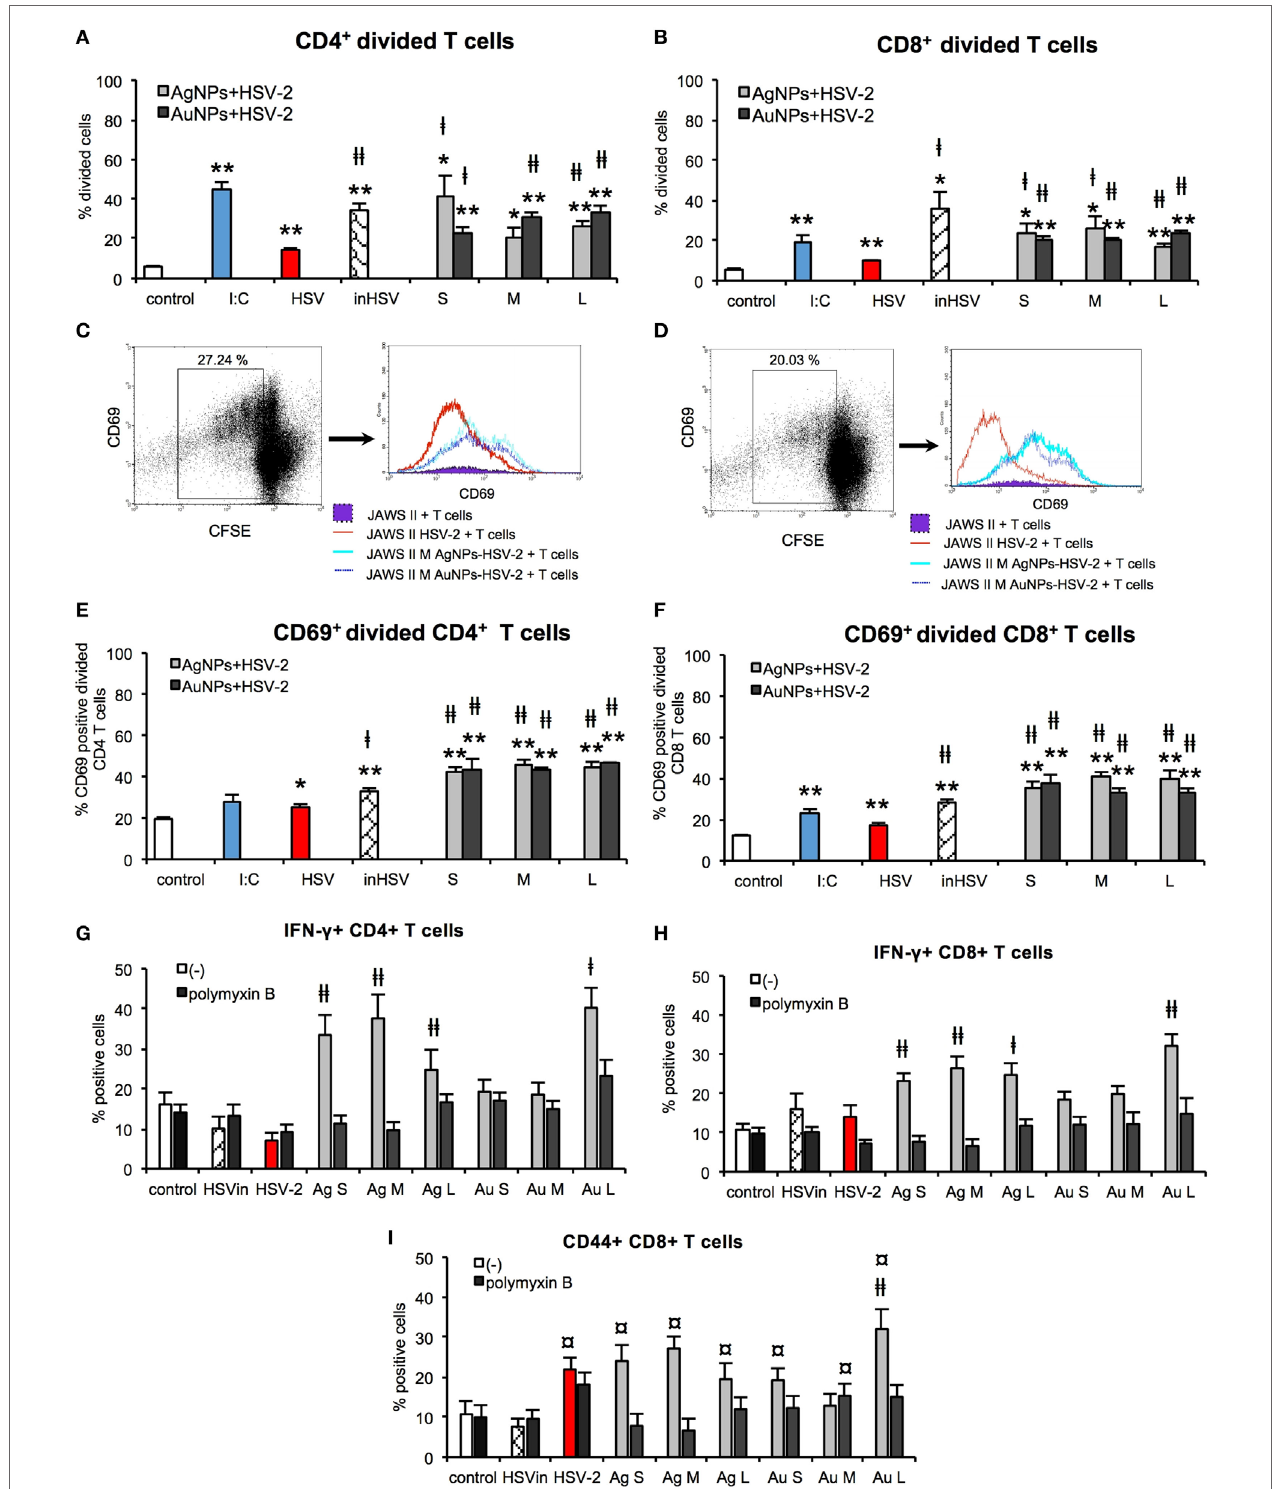
FigUre 11 | Nanoparticles (NPs) enhance the ability of dendritic cells (DCs) to activate T cells in vitro . Percentage of divided CD4 + (a) and CD8 + T cells (b) . Representative dot plots and histogram plots of CD69 + CD4 + (c) and CD69 + CD8 + (D) divided T cells. Percentage of CD69 + divided CD4 + (e) and CD69 + divided CD8 + T cells (F) . Percentage of IFN- γ+ CD4 + (g) and IFN- γ+ CD8 + T cells with or without 10 µg/ml polymyxin B (h) . Percentage of CD44 + CD8 + T cells with or without 10 µg/ml polymyxin B (i) . Each bar represents the mean from 3 experiments ( N = 3) ± S.E.M. *Significant differences with p ≤ 0.05, ** p ≤ 0.01 in relation to untreated control, ‡ p ≤ 0.05, and ‡‡ p ≤ 0.01 calculated in relation to the HSV-2 infected control. ¤ p ≤ 0.01 calculated in relation to the inactivated